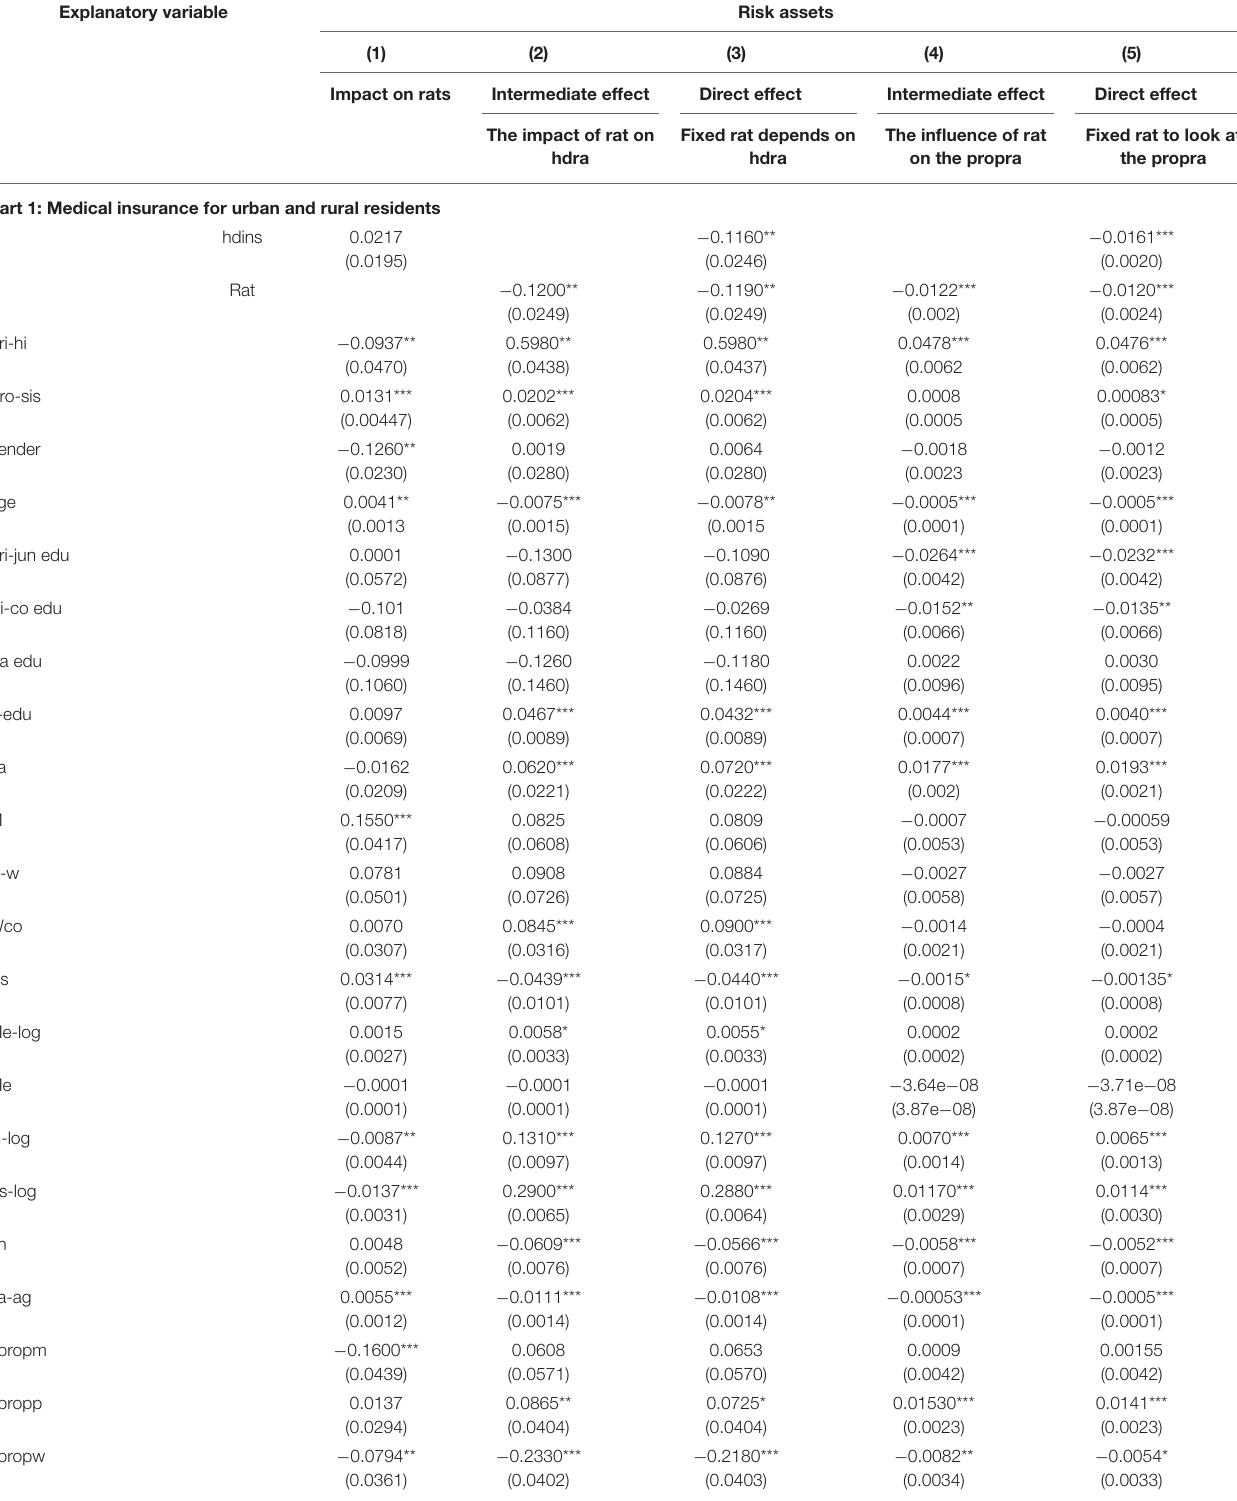
TABLE 6 | Intermediary effect regression (replacing definitions of financial assets, risk